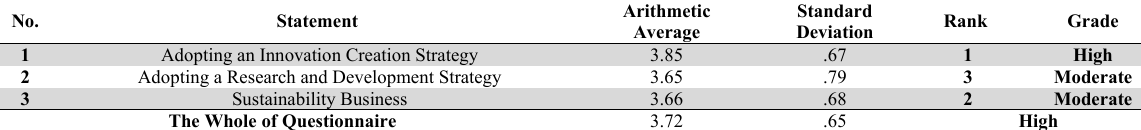
The arithmetic means and standard deviations of the questionnaire axes